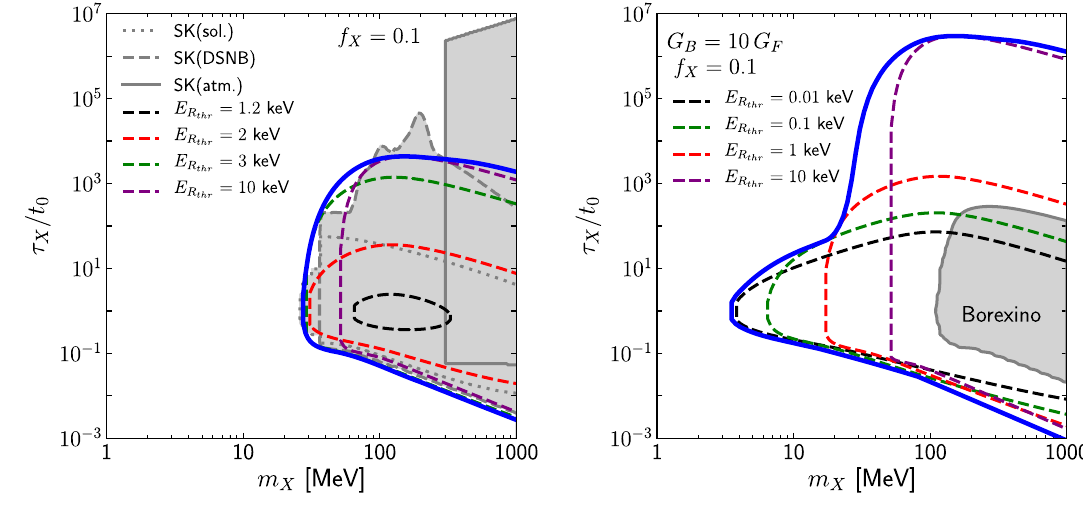
labeled.Thethickbluelineisthemaximumofallcurves.Thegrayareas in the left (right) panel show excluded regions from SK (Borexino) and are taken from [45]